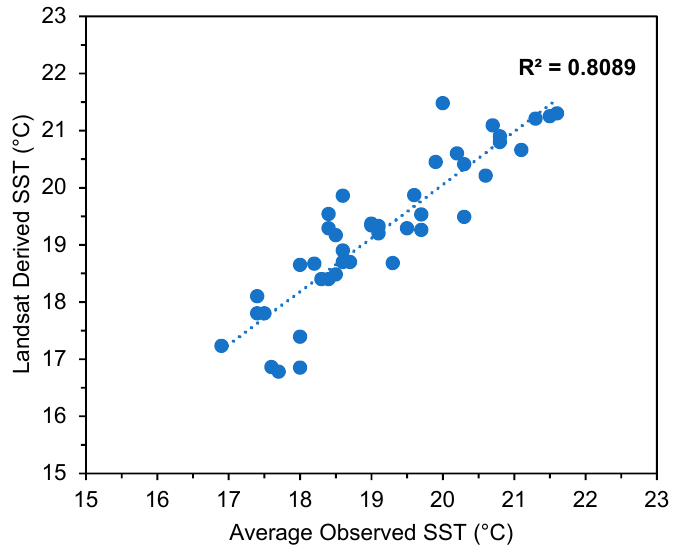
Figure 3. Correlation of the Sea Surface Temperature between the derived SST from Landsat 8 and observed SST in replicated points along the Portuguese coast.